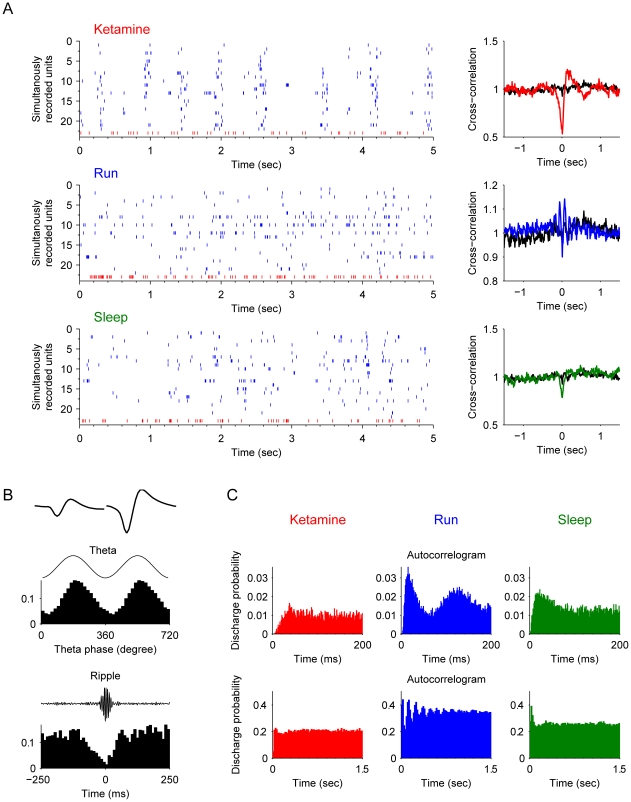
Properties of type-3 interneurons (putative chandelier cell, also termed as axoaxonic cell).(A) Spike rasters of chandelier interneurons (red) and simultaneously recorded pyramidal cells (blue) after ketamine injection, during running and slow-wave sleep are show (left panels). The cross-correlation functions of the interneuron and pyramidal cell joint-activities are plotted on the right. The black line is the cross-correlation during the awake rest state. The upper right panel shows this unit has negative correlation with pyramidal cell activities. (B) The properties of this example interneuron. The most upper left panel shows the average spike waveforms. The middle left panel illustrates the spike timing of this unit is strongly coupled with theta oscillations (p<0.001, Rayleigth's test). The lower left panel shows the firing rate significantly decreased during ripple epochs. (C) Autocorrelograms in different states: after ketamine injection, during running, and during sleep respectively. Autocorrelograms are shown in two time windows: 0–200 ms and 0–1.5 sec.